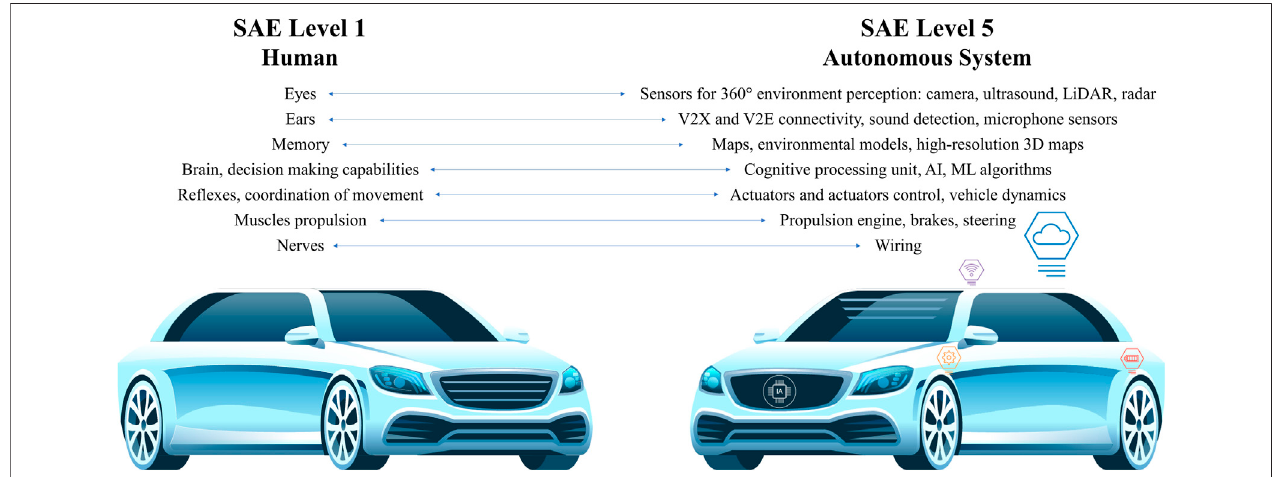
FIGURE 1 | Autonomous vehicle intelligence and senses compared with the driver